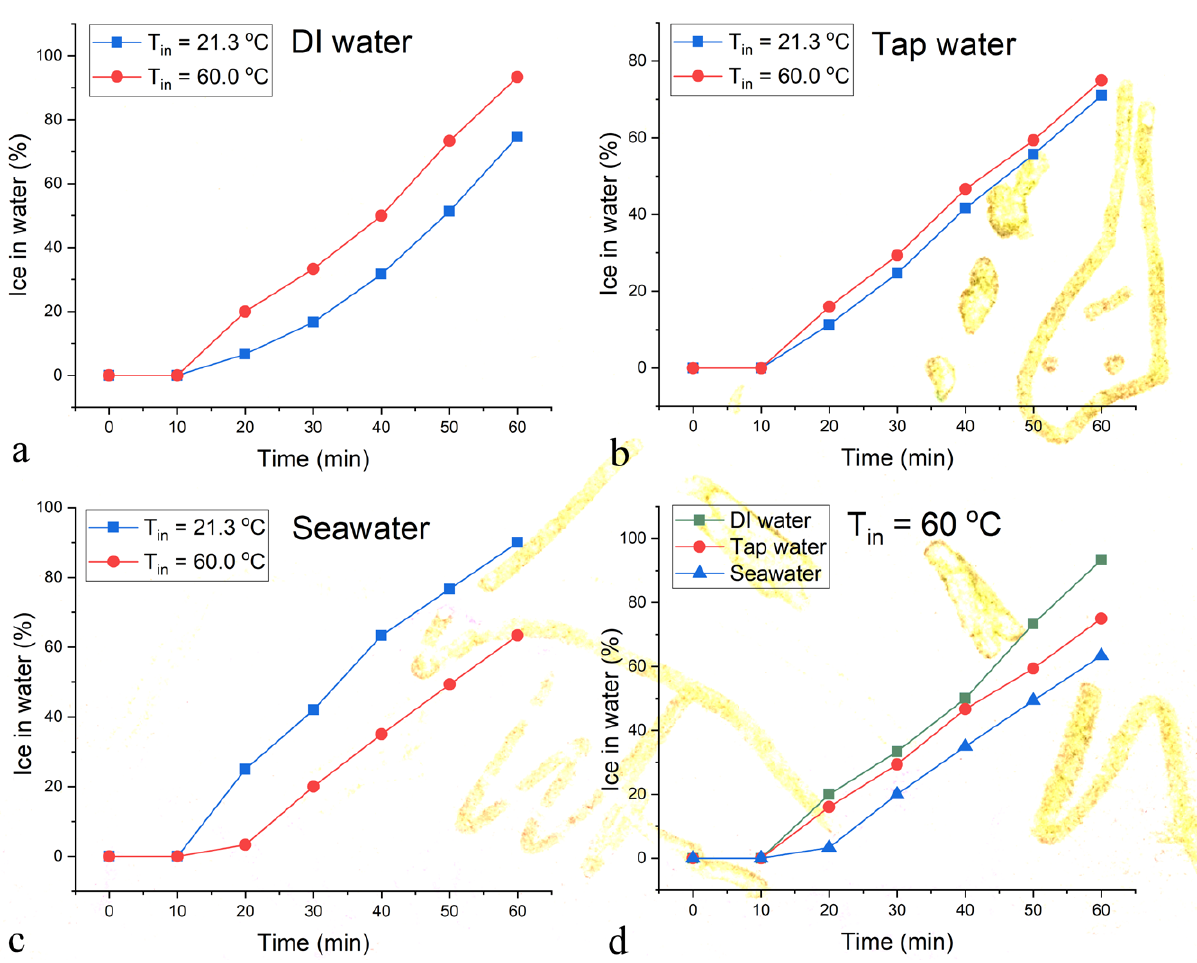
Figure 2. Percentage of the total volume of ice in the 30 ml water samples as a function of the time of incubation at -18 o C for different starting temperatures, including 25 and 60 o C, for DI water (a), tap water (b) and seawater (c), along with the comparison between the per- centage of the solid phase for the three different waters starting at 60 o C as a function of time